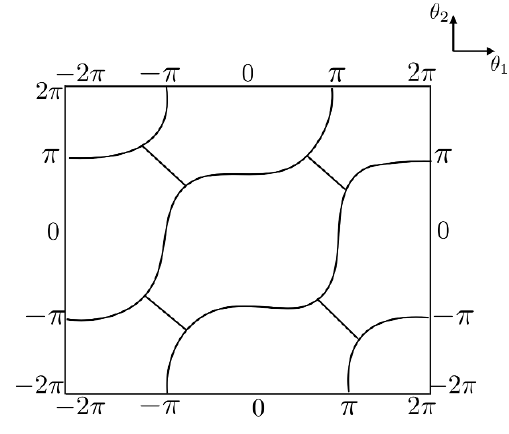
Figure 1 . The topology of the phase diagram of the equal rank bi-fundamental gauge theory for some (cid:12)xed M; (cid:3) 1 ; (cid:3) 2 as a function of (cid:18) 1 ; 2 . In various limits of the theory one can compute the shape of the phase transition